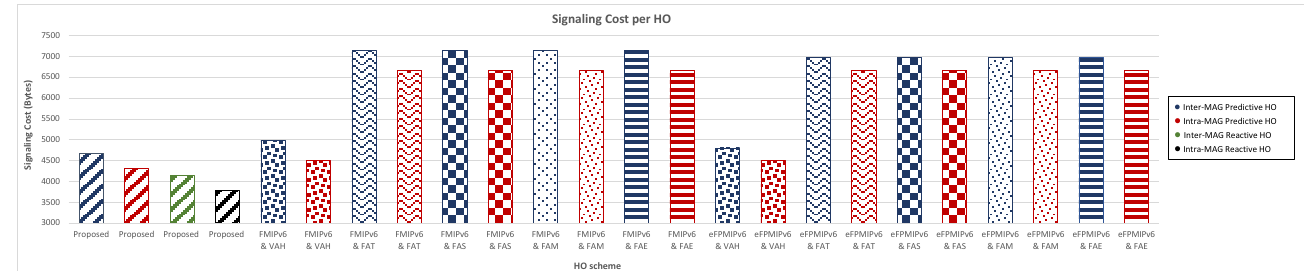
Figure 21. The signaling cost of each HO